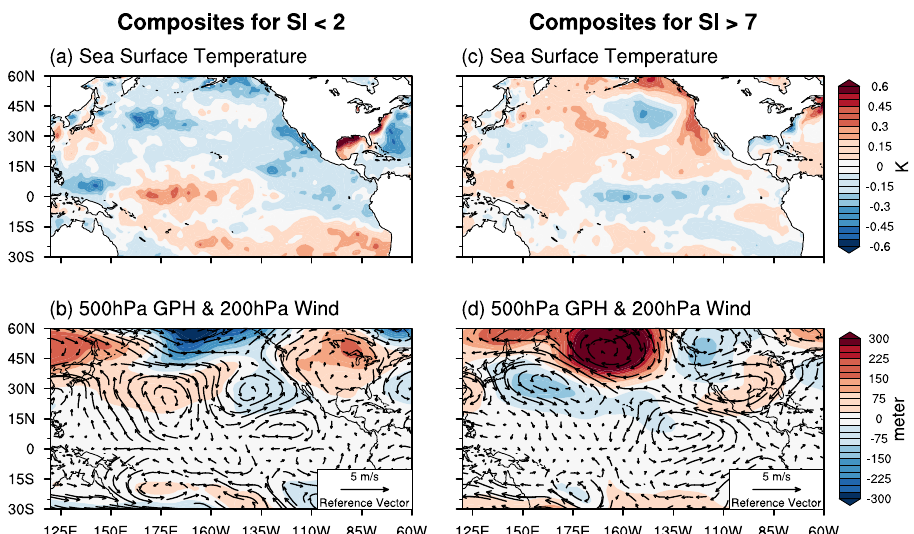
Fig. 3 Oceanic and atmospheric conditions during years with mild and severe bloom activity. a Anomalies of SST ( ˚ C) for December, January, and February for years with HABs SI < 2. b Anomalies of 500-hPa geopotential height (shaded, m) and 200-hPa wind (vector, m s − 1 ) for December, January, and February for years with HABs SI < 2. c Same as ( a ) but for HABs SI > 7. d Same as ( b ) but for HABs SI > 7. SSTs were obtained from HadISST (Rayner et al. 54 ), and geopotential height and winds were obtained from the ERA5 reanalysis. Anomalies were calculated after subtracting the climatology based on 2002 – 2020.